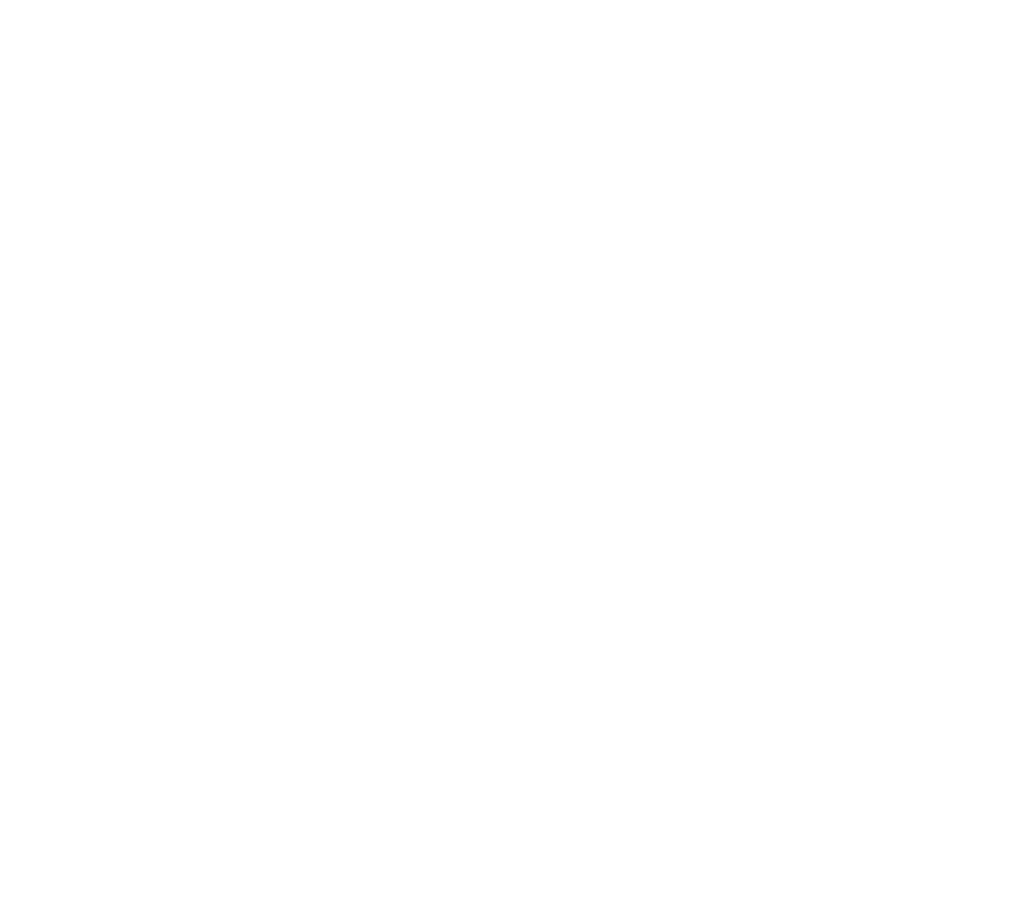
Figure 1 Minor adverse events in 440 patients receiving propofol